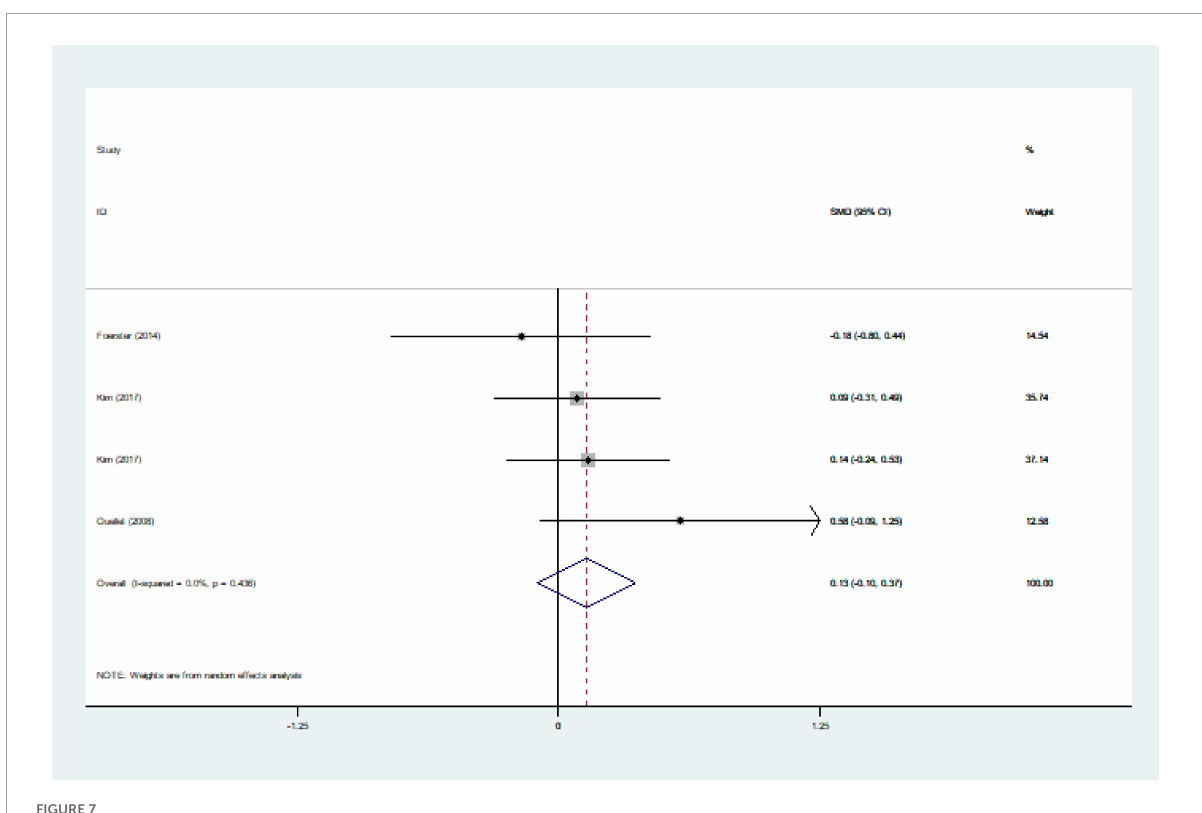
FIGURE7 Effect of red meat consumption on CRP or hs-CRP concentration. CRP, C-reactive protein; hs-CRP,